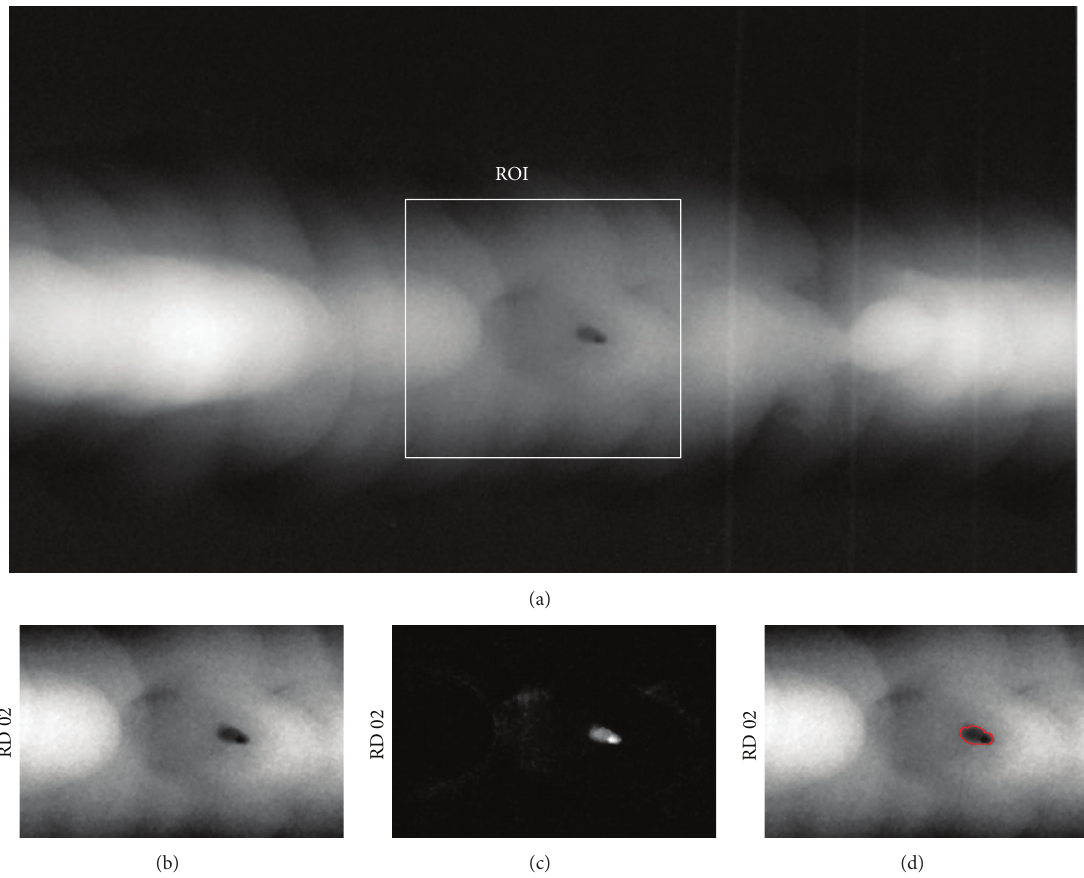
Figure 5: Weld defect detection with the proposed active contour: (a) the whole weld radiogram, (b) ROI selected image, (c) off-center saliency map, and (d) final segmentation with proposed level set active contour (red